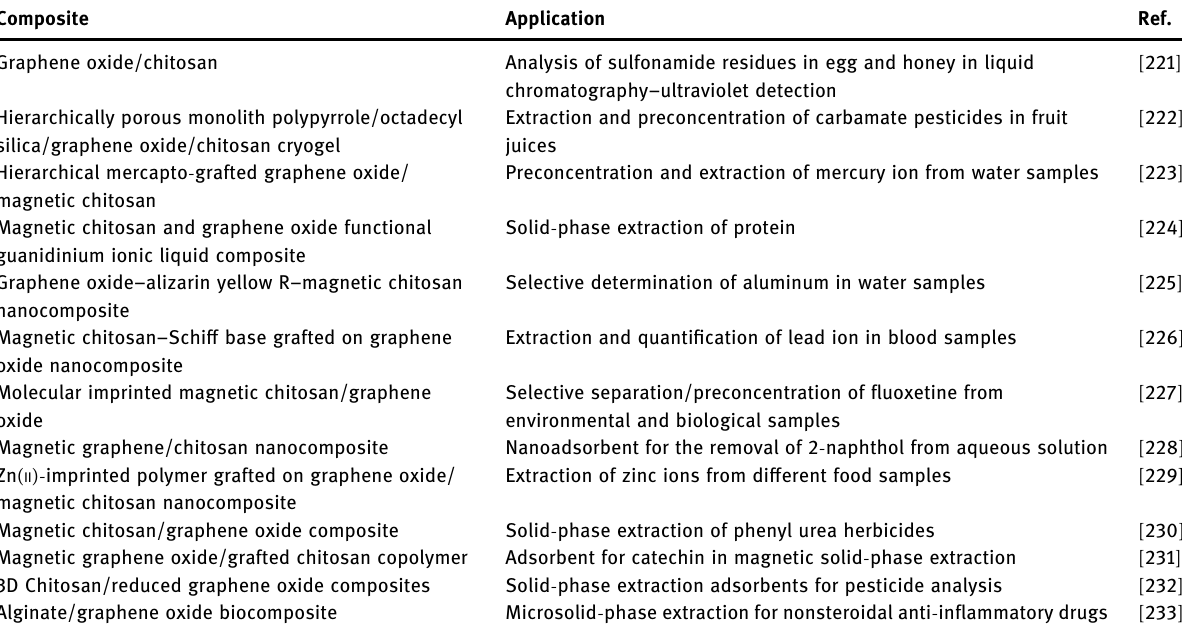
Table 4: Some conducted studies on biopolymer/graphene - based composites in microextraction Composite